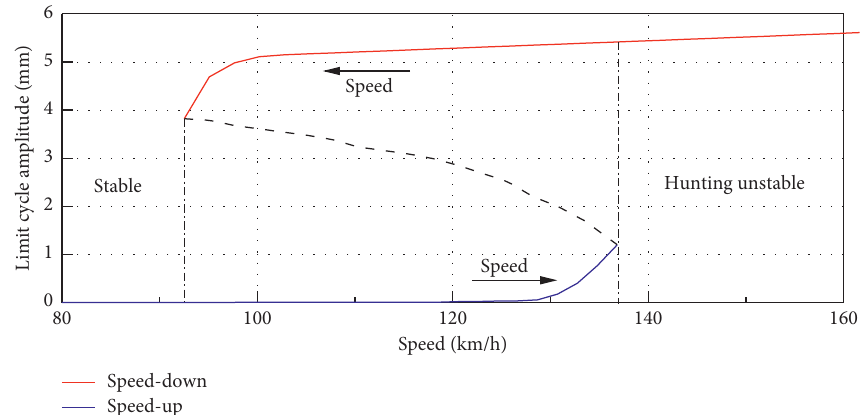
Figure 18: Hopf bifurcation diagram.